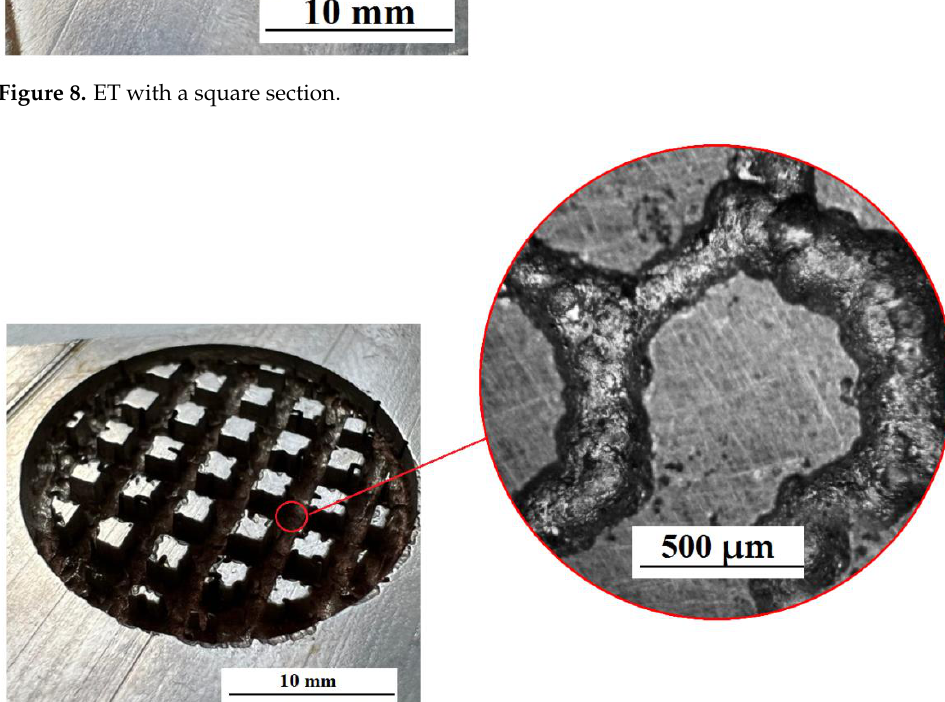
Figure 8. ET with a square section.